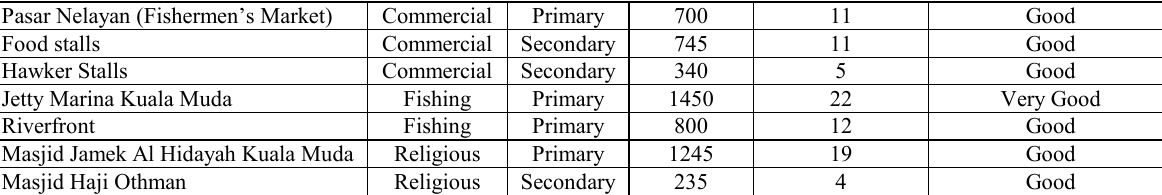
Table 3. Node data